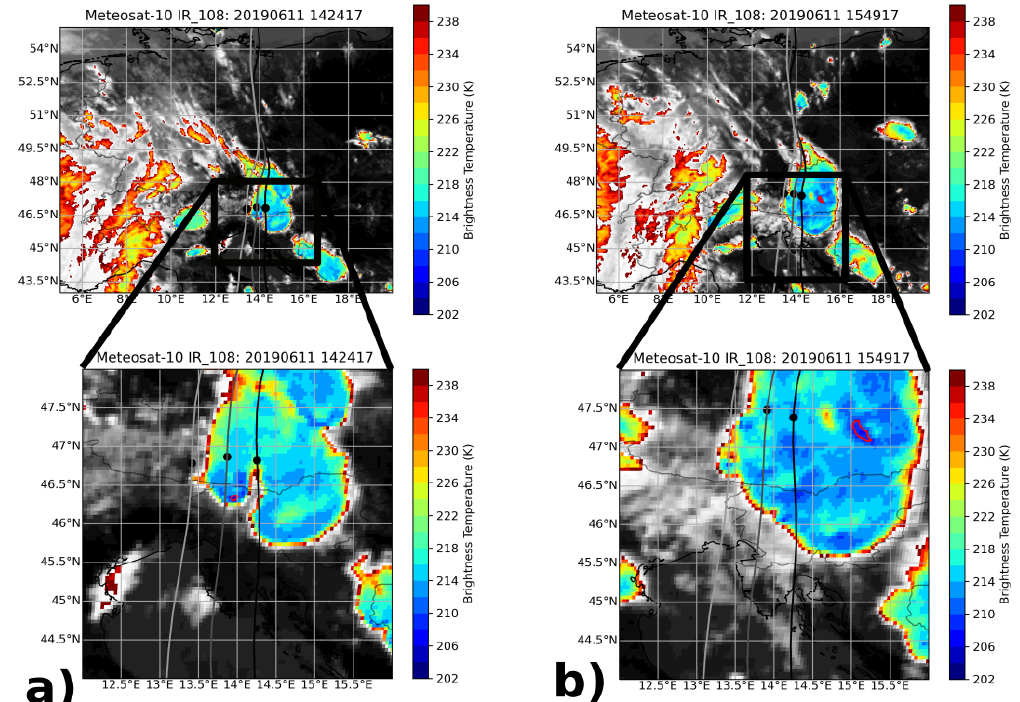
Figure 12. Same as Fig. 11 but for case 2. Air mass trajectories initiated at different pressure levels (144, 153, and 155hPa) are shown with gray to black lines. Air masses with BT < 209K are denoted with pink contours. Panel (a) shows the satellite image at 14:24UTC and panel (b) at 15:49UTC on 11 June